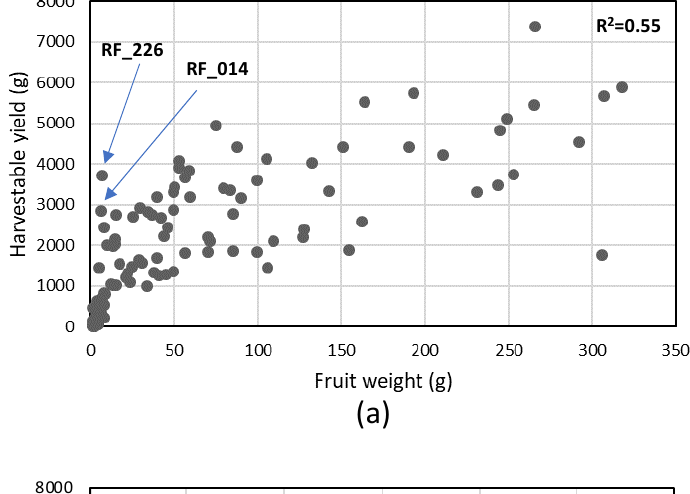
Figure 5. Scatter plot of fruit number versus fruit weight.